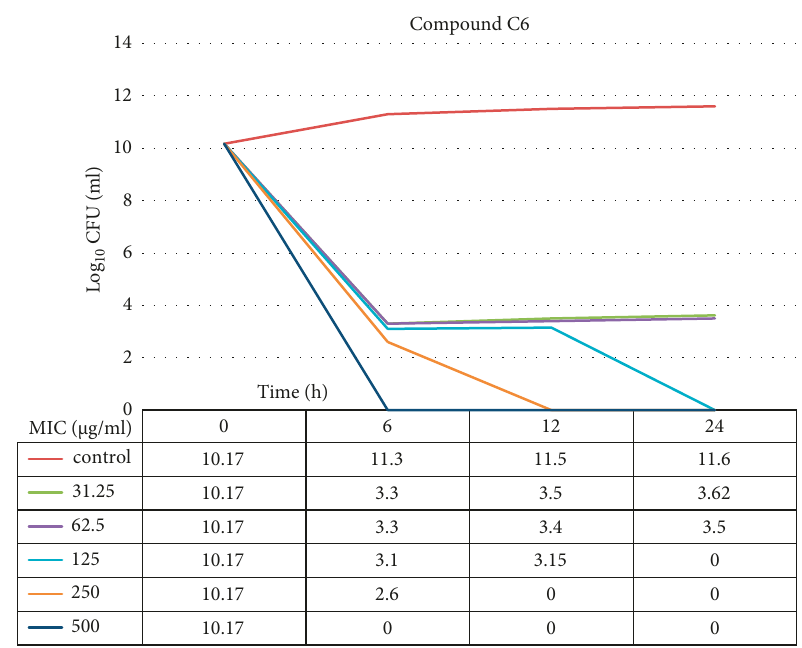
Figure 11: Time-kill assay of the C6 compound from 1X to 16X of MIC for 6, 12, and 24 hours against S. aureus isolates.